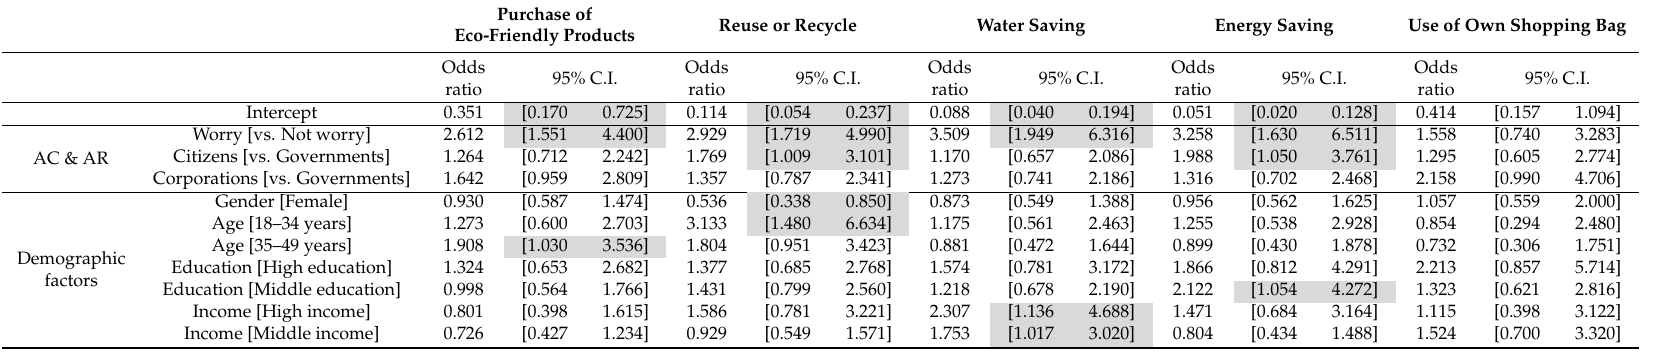
Table A2. Logistic regression analysis of causal effects of AC, AR, and demographic factors (odds ratio and its 95% confidence